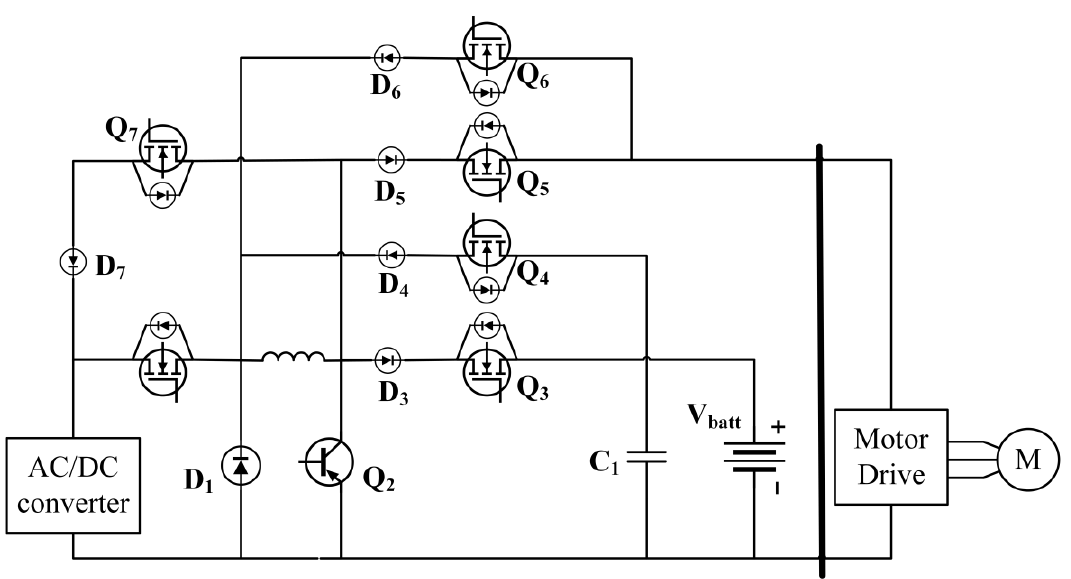
Figure 55. Integrated bidirectional AC/DC-DC/DC converter [33].